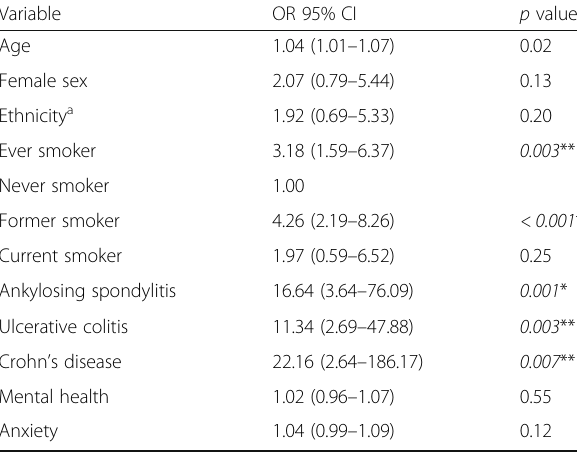
Multivariate variable is corrected for age and gender a Reference group for ethnicity: non-Hispanic whites *Significant at the 0.001 probability level **Significant at the 0.01 probability